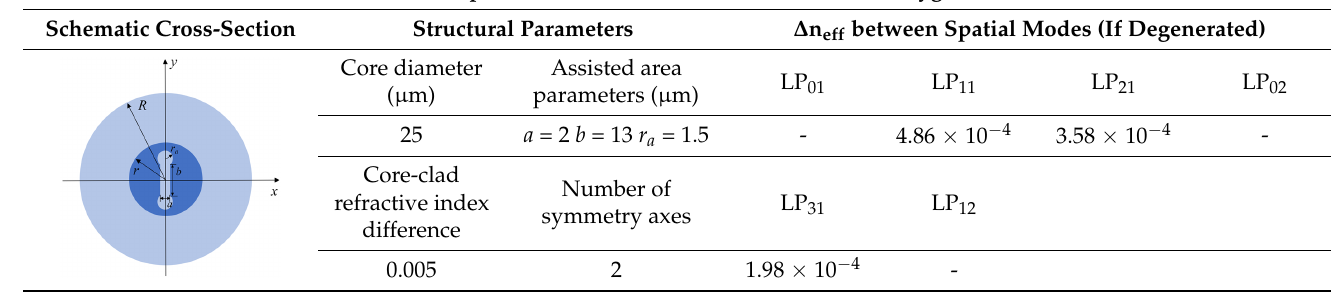
Table 5. Mode properties when the central-assisted area is a convex polygon (at the wavelength of 1550 nm). The Shape of the Central-Assisted Area: Convex Polygon